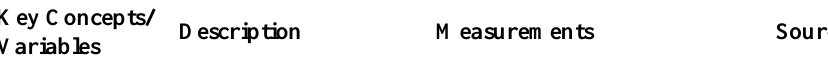
Table 1: Operationalisation of Variables Key